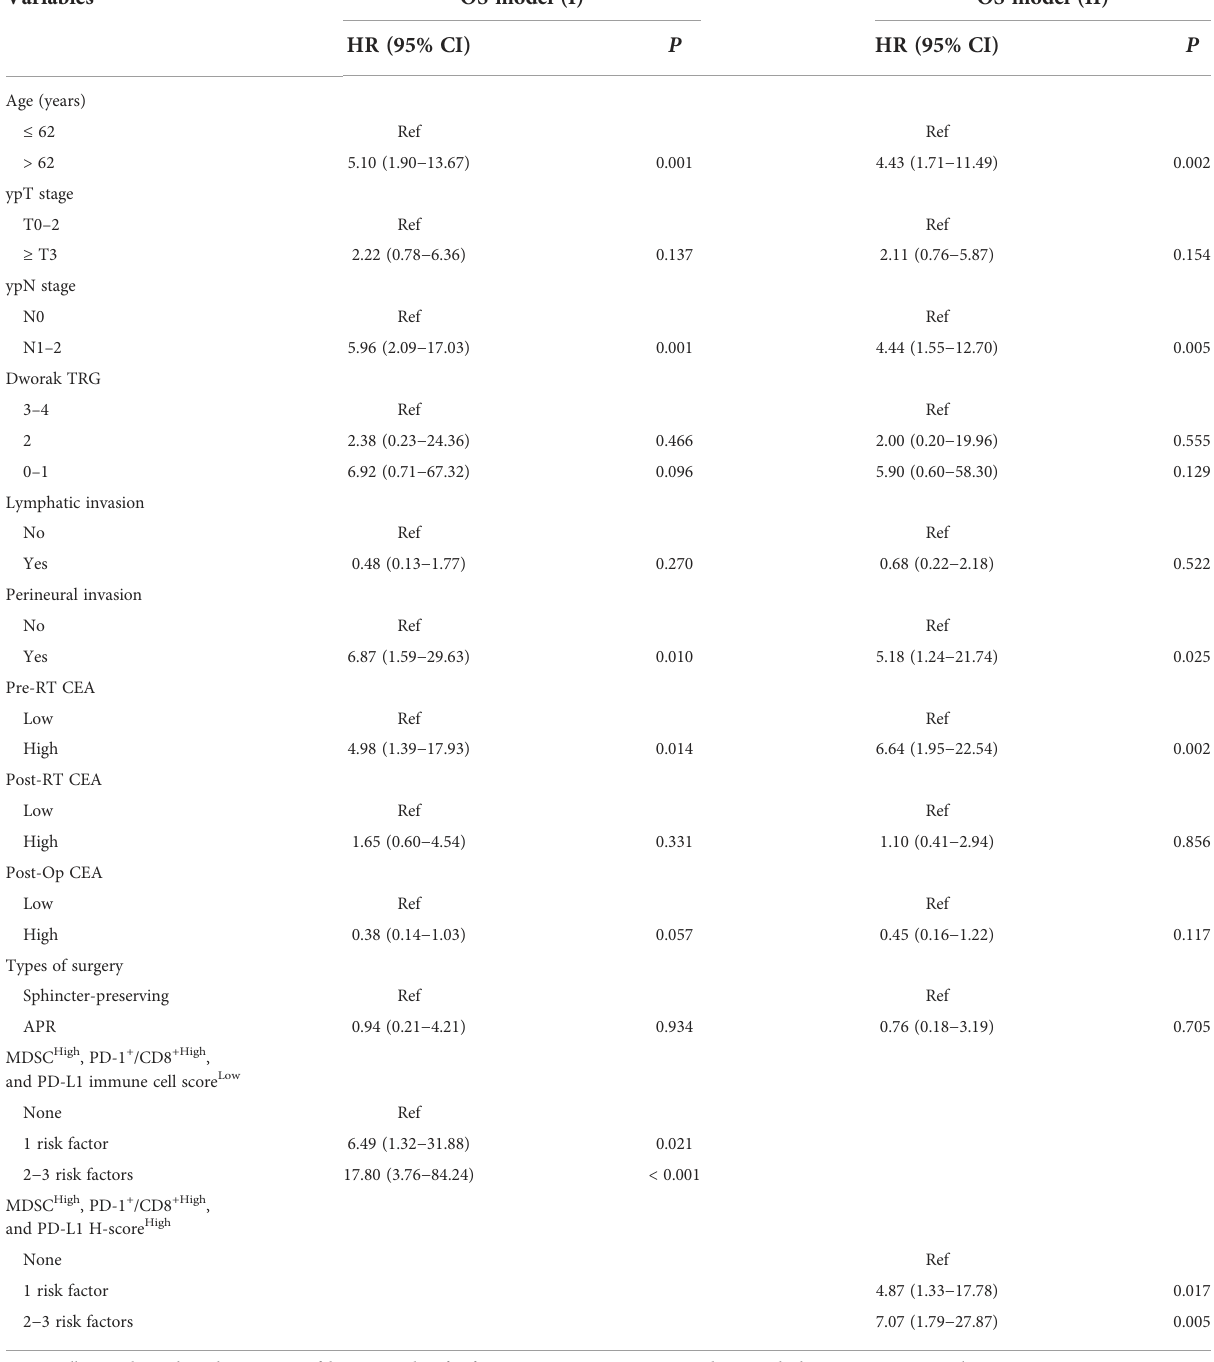
TABLE 2 Cox proportional-hazards regression models for overall